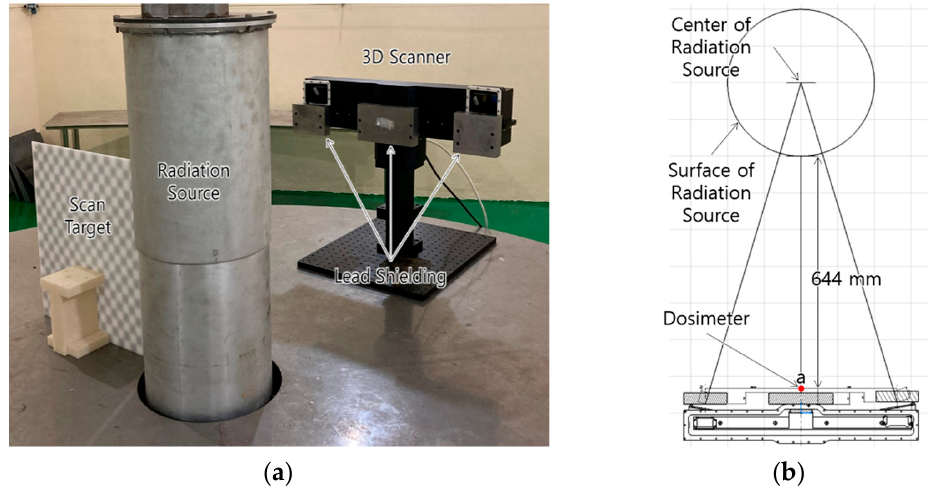
Figure 9. Verification Experiment: ( a ) Experimental Setup; ( b ) Detailed Layout Drawing.